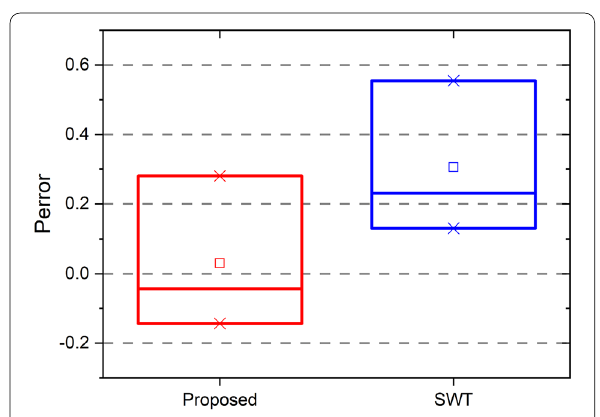
Figure 19 Prediction error of rolling bearing